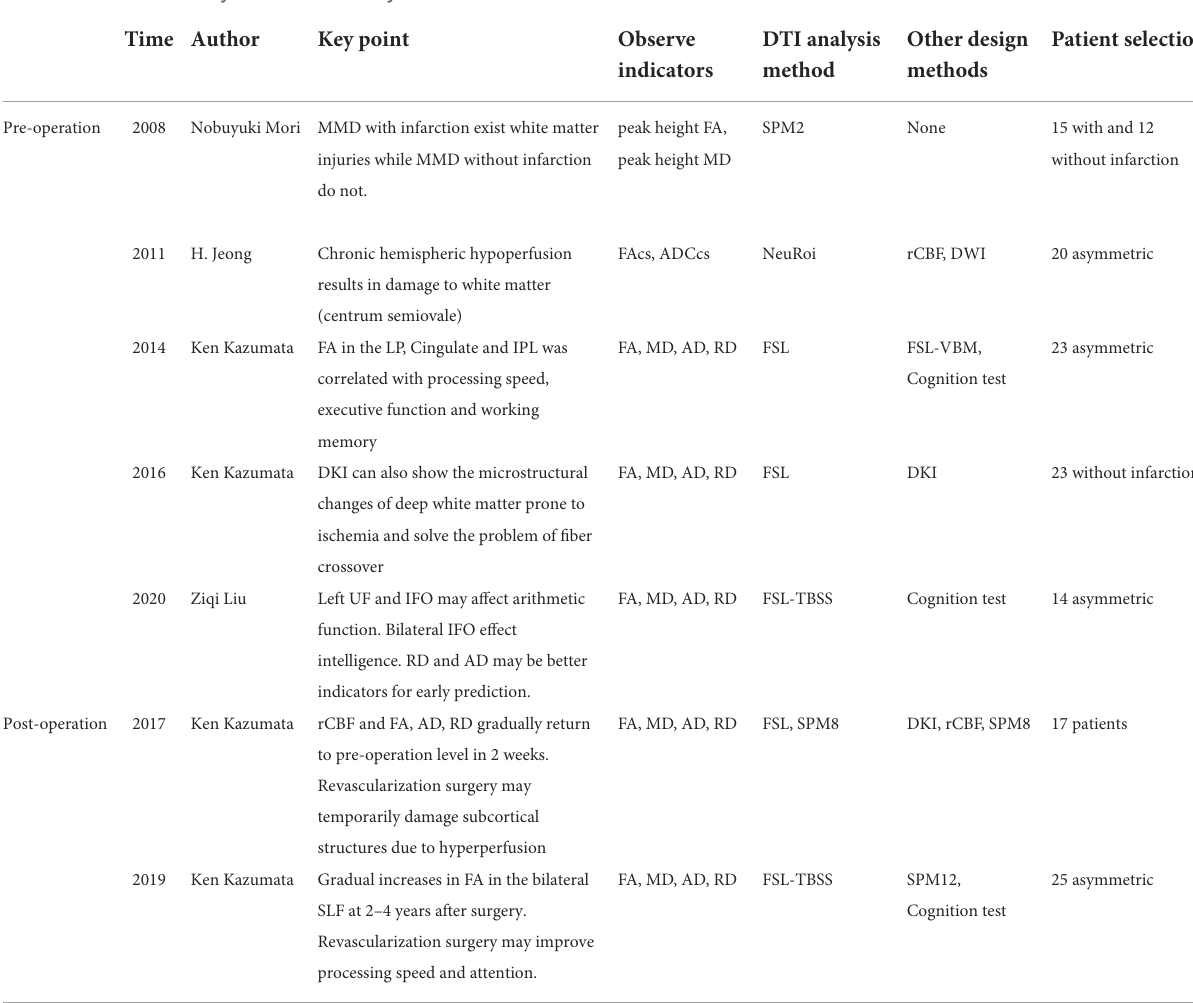
TABLE 1 Studies in recent years about DTI analysis of